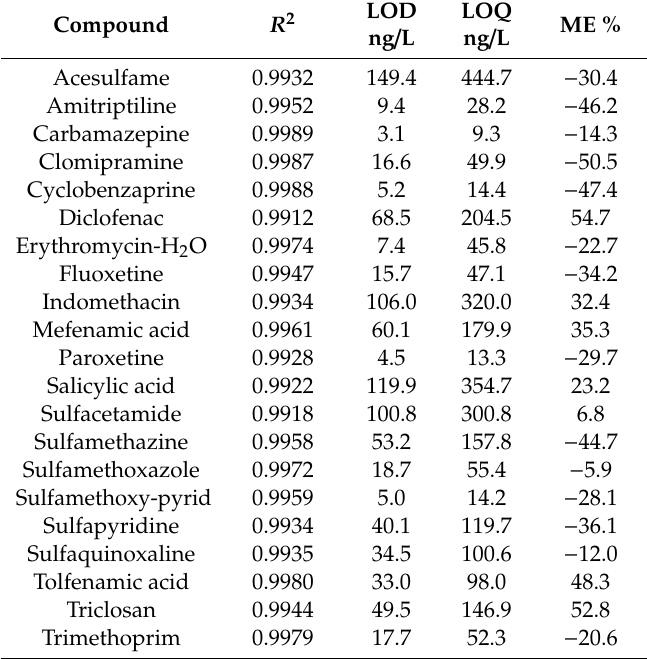
Table 1. Linearity as correlation coe ffi cient ( R 2 ), Detection and Quantification Limits and Matrix E ff ect values (ME